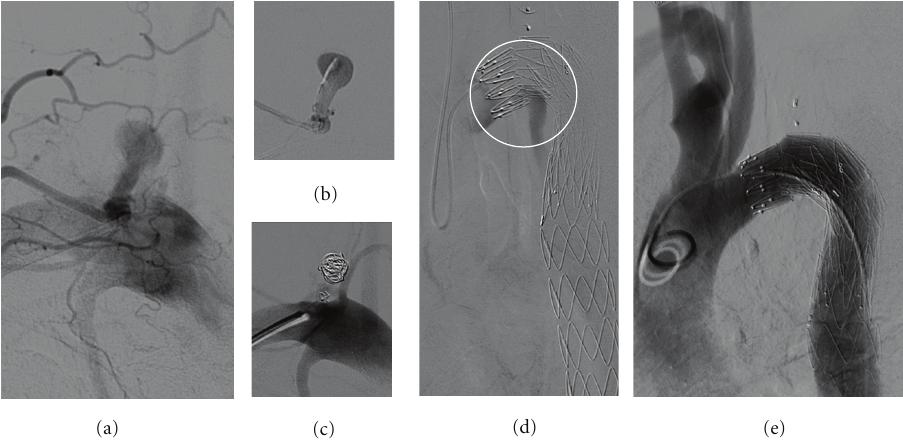
Figure 3: (a) Selective angiography of the left subclavian artery showing iatrogenic pseudoaneurysm after central line placement. (b) Selective intraaneurismal angiography was performed with a 1.9Fr microcatheter showing a long neck. (c) Result after embolization with microcoils demonstrating complete occlusion of the sack. (d) Selective angiography using a 5Fr Sidewinder catheter shows a type I leak which can also be found on the angio-CT. (e) After angioplasty of the proximal endoprosthesis body the type I endoleak could be sealed